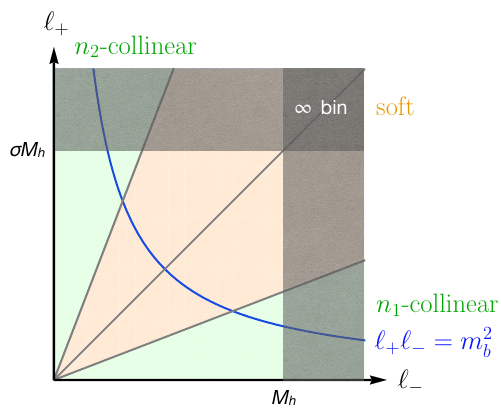
Figure 1: Soft and collinear regions in the ` ` + plane. Contour of constant ` + ` are hyperbolas    in this plane. The separation of the three regions must be regularized using rapidity regulators. Figure 2 . Graphical illustration of the subtractions performed in the rearrangement of the factor- ization formula, which removes the endpoint divergences of the various